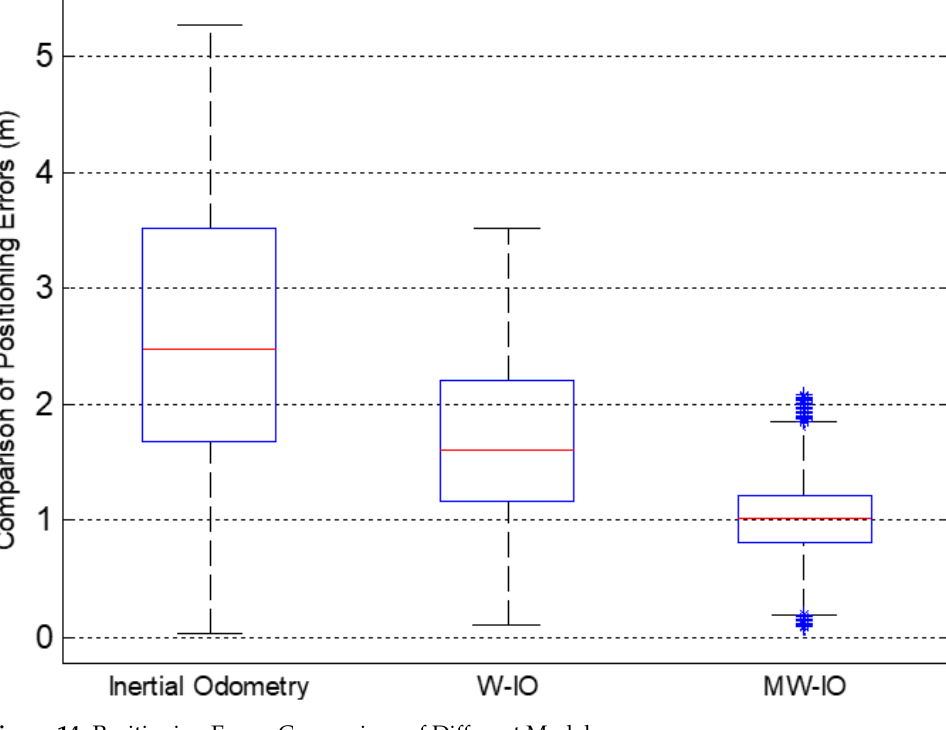
Figure 14. Positioning Errors Comparison of Different Models. Table 1. Positioning Errors Comparison of MA-PF and